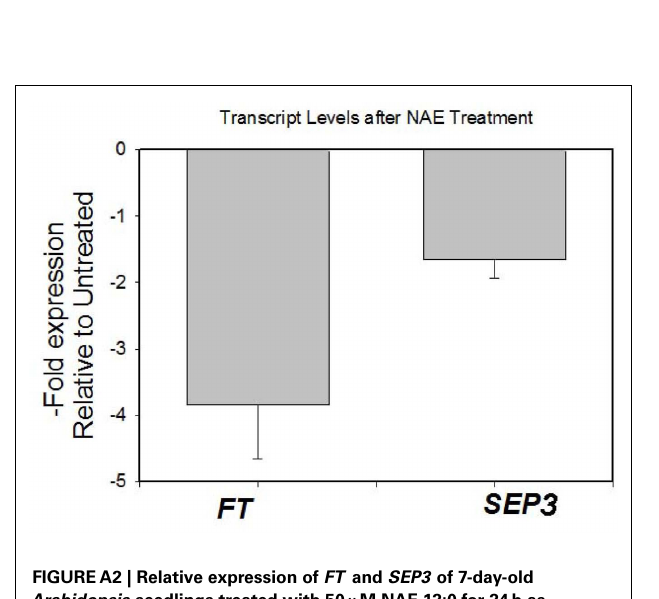
FIGUREA2 | Relative expression of FT and SEP3 of 7-day-old Arabidopsis seedlings treated with 50 μ M NAE 12:0 for 24h as determined by quantitative